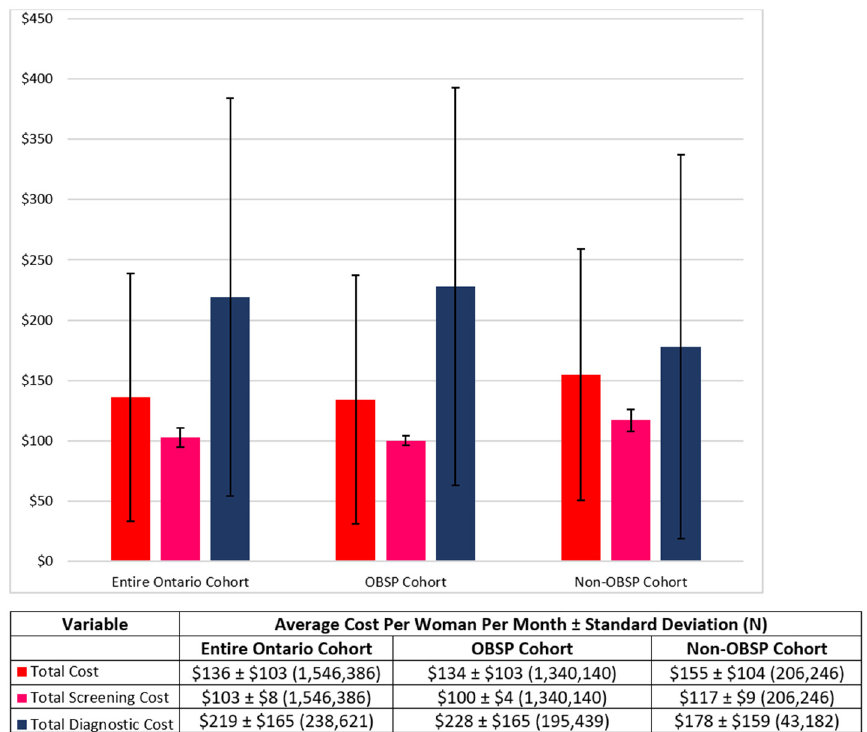
Figure 1. Average Costs Per Month for Entire, OBSP and Non ‐ OBSP Cohorts.